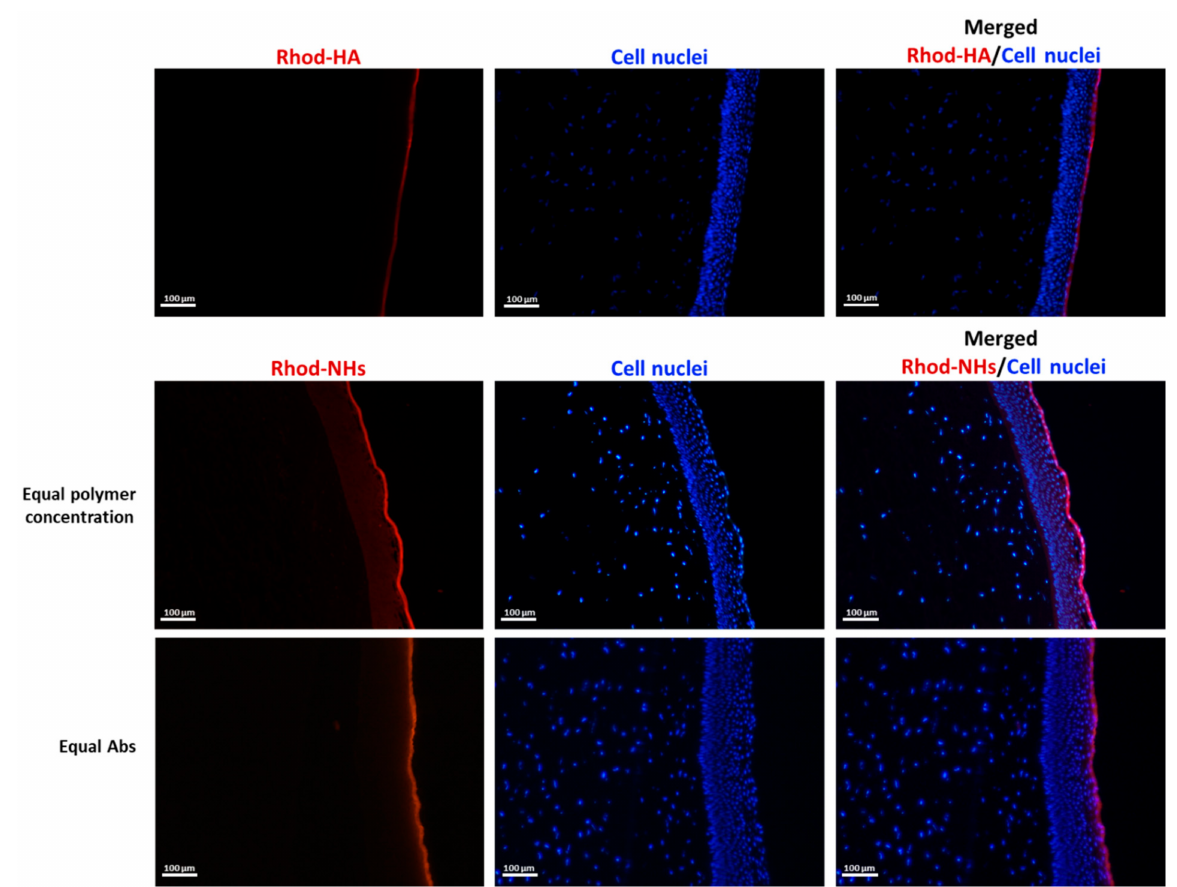
Figure A1. Fluorescence micrographs (scale bars: 100 µ m) of vertical slices of porcine cornea after 4 h of incubation with Rhod-HA or